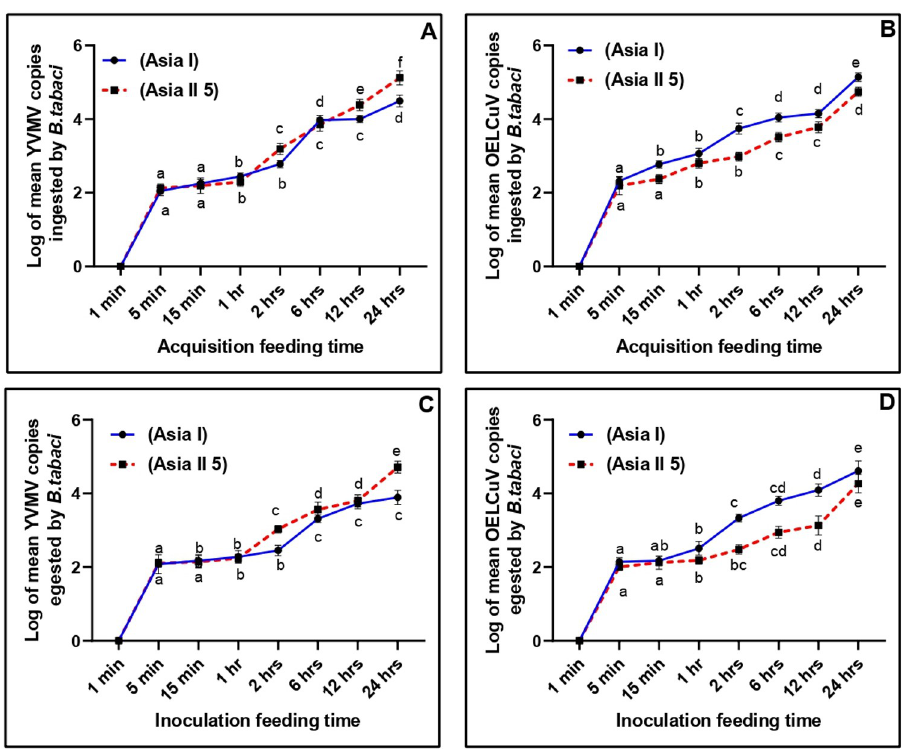
Fig 4. Dynamics of YVMV and OELCuV copies ingested (A and B) and egested (C and D) by individual Asia I and Asia II 5 genetic group of B . tabaci . Acquisition/ Inoculation feeding time is expressed on X-axis and log of virus copy number is plotted on Y-axis. YVMV and OELCuV copies were estimated at 1 min, 5 min, 15 min, 1 hr, 2 hrs, 6 hrs, 12 hrs, and 24 hrs of feeding. The different letters indicate statistically significant differences between the treatments. The bars represent the standard error of mean ( ±